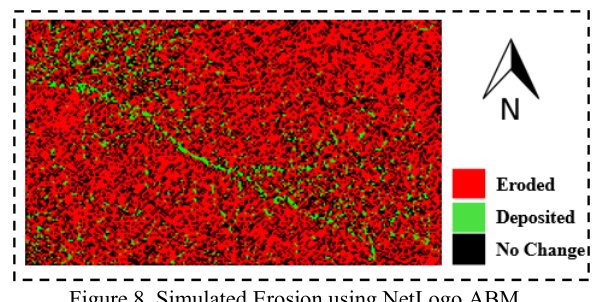
Figure 8. Simulated Erosion using NetLogo ABM.